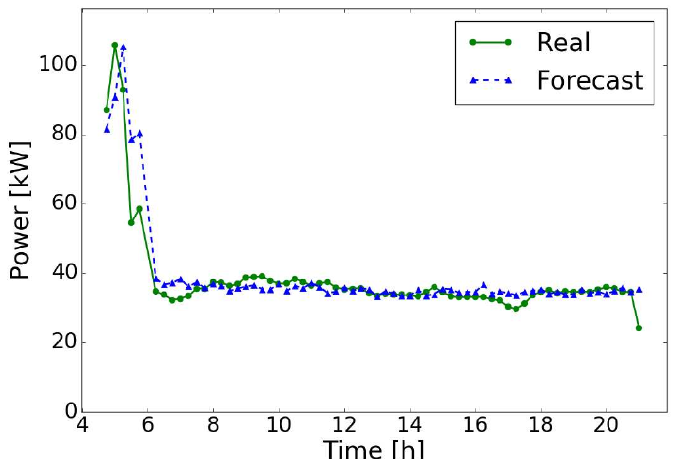
Figure 7. Daily 15 min average power prediction for a single-cycle building with 1-h advance (5% maximum error on weather